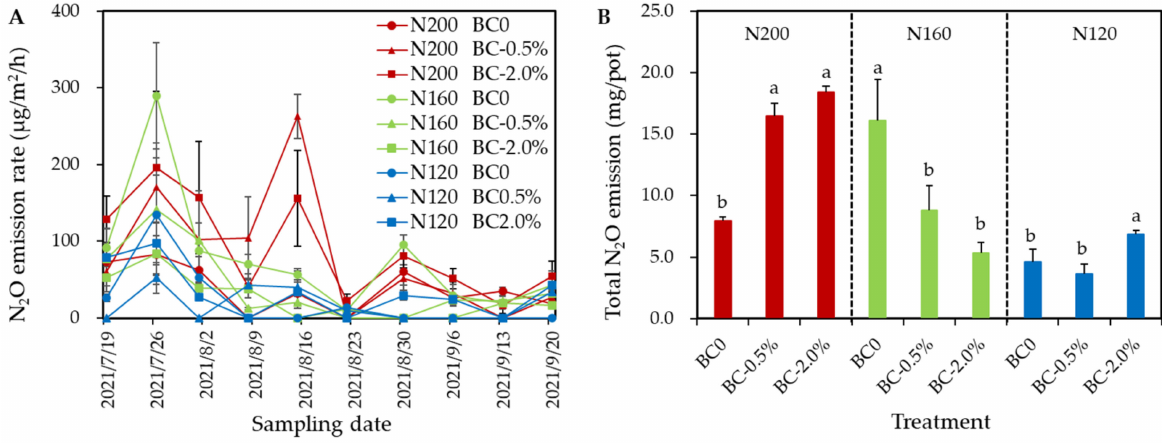
Figure 4. Effects of biochar on the N 2 O emission rate ( A ) and the total N 2 O emission flux ( B ) in a water-spinach-planted vegetable soil receiving three N inputs. Error bars represent the SD of the mean of three replicates. Different letters above column chart indicate the differences between each treatment with same N input were statistically significant, according to Duncan’s post hoc test at level of p <